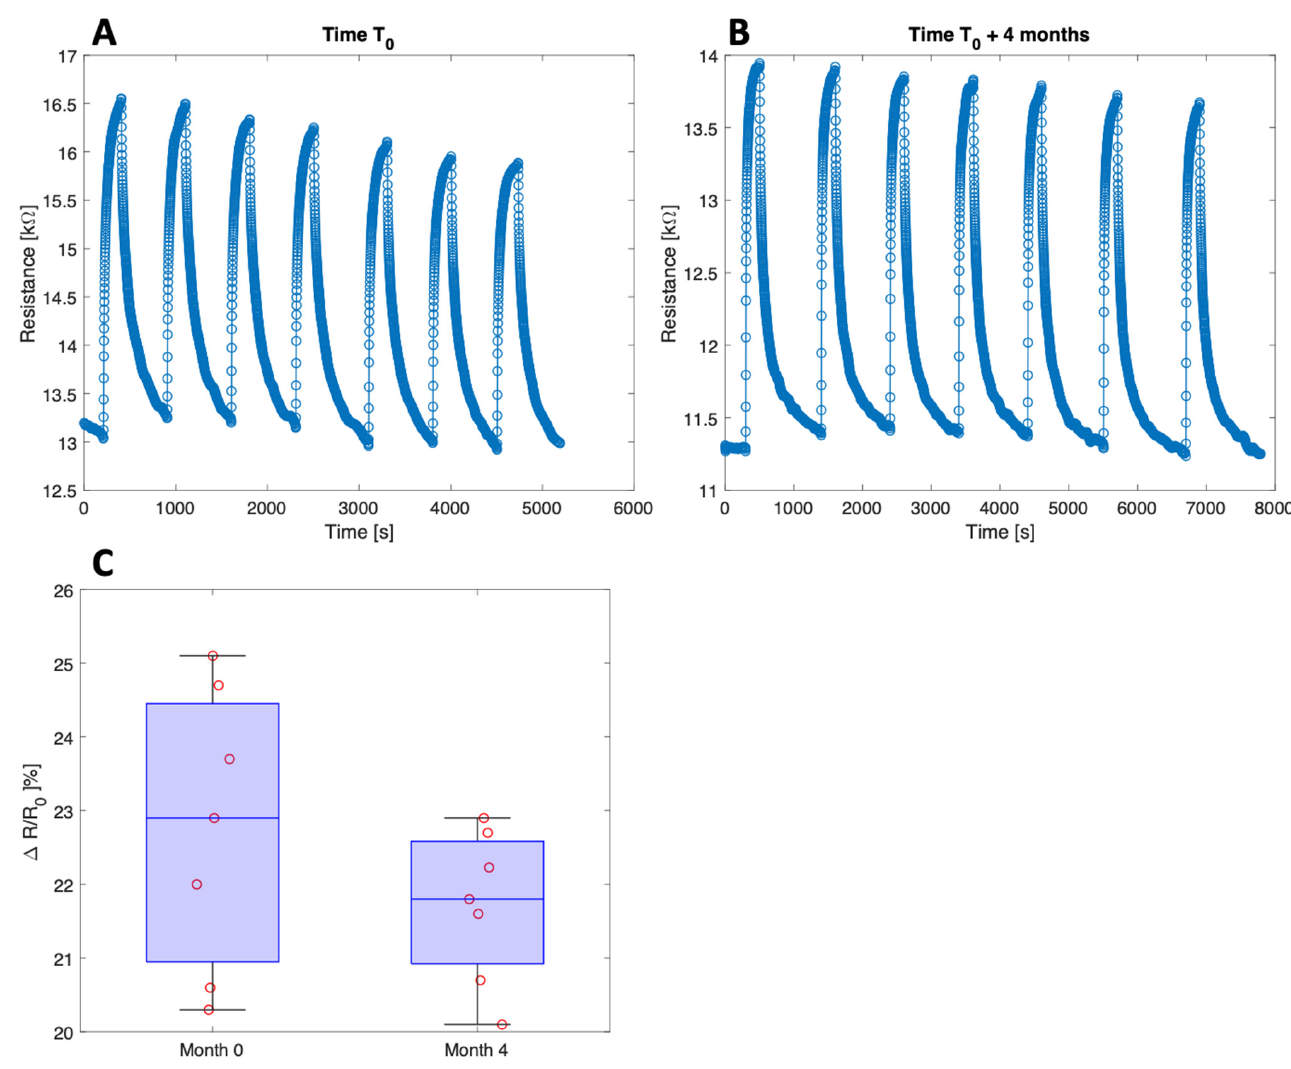
Figure 14. Repeatability and stability tests. ( A ) Sensor dynamic resistance under consecutive expo- sures to 100 ppm ammonia at 45% relative humidity; ( B ) same measurement repeated four months later. ( C ) Comparison of sensor responses.